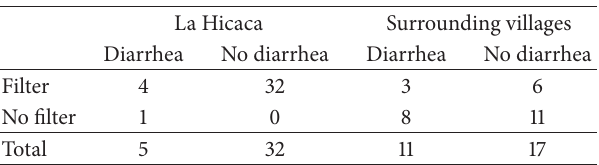
Table 4: Filter use and diarrheal illness in La Hicaca and surround- ing